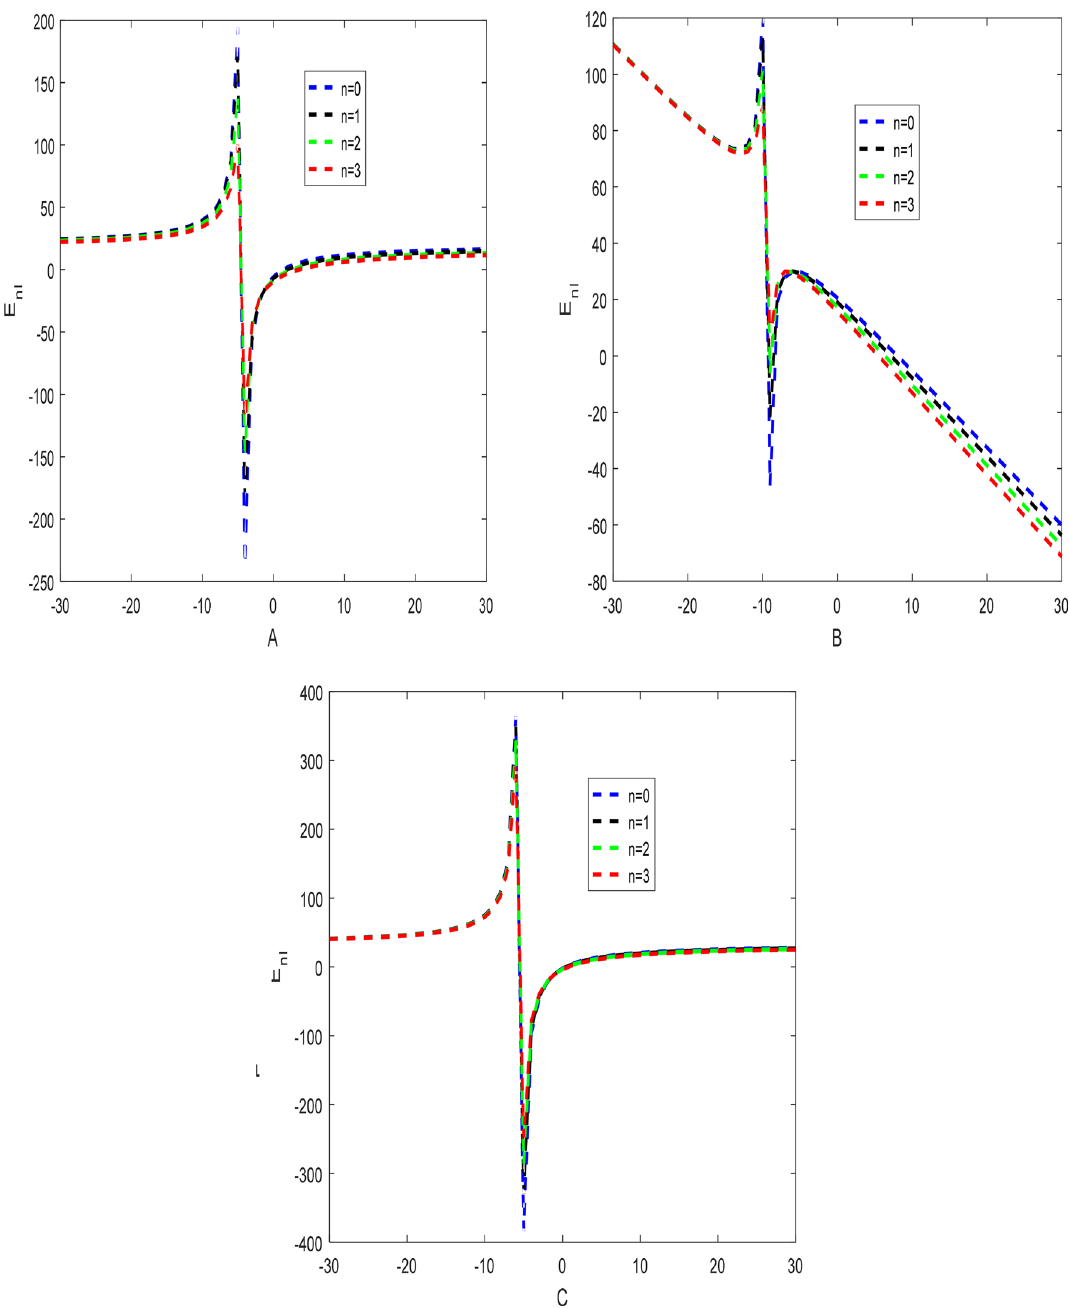
Figure 1. Variation of energy against ( A , B , C )